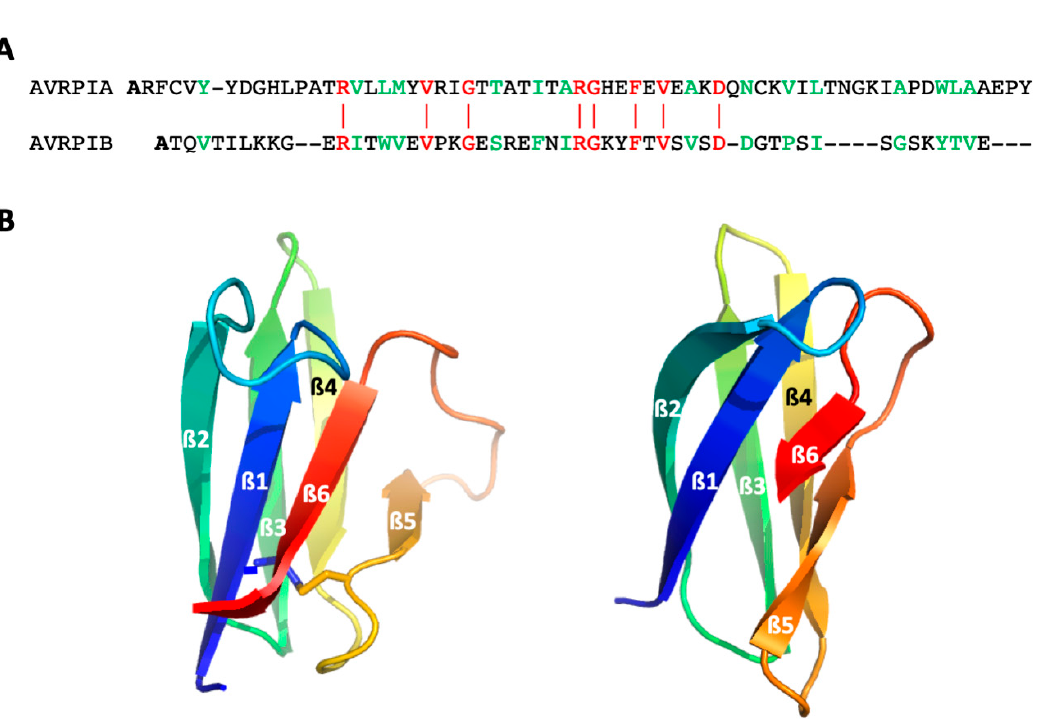
Figure 1. The structure of AVR-Pia and AVR-Pib. ( A ) sequence alignment (DALI [25]) of the two proteins. Residues colored in red correspond to identical residues in the two sequences. Sequence identity ( ≈ 12%) is further highlighted by the red vertical lines between the two sequences. Residues colored in green corresponds to homologous residues between the two sequences ( ≈ 35% sequence homology); ( B ) Cartoon representation of AVR-Pia (PDB: 6Q76 [26]) (left) and ( B ) AVR-Pib (PDB: 5Z1V [27]) (right) structures. The six strands are labeled ß1 to ß6, and the structures are colored from the N-ter in dark blue to the C-ter in red. The SS-bridge in AVR-Pia is shown by sticks.